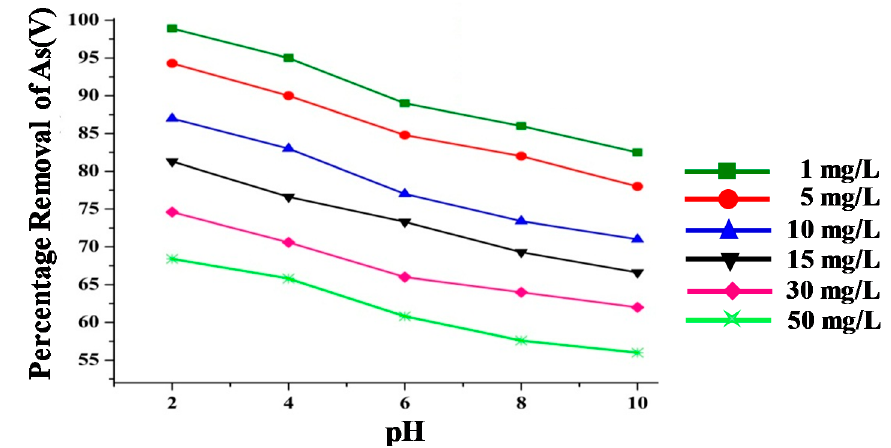
Figure 8. As(V) removal efficiency at different pH levels and arsenic concentration by IONPs.